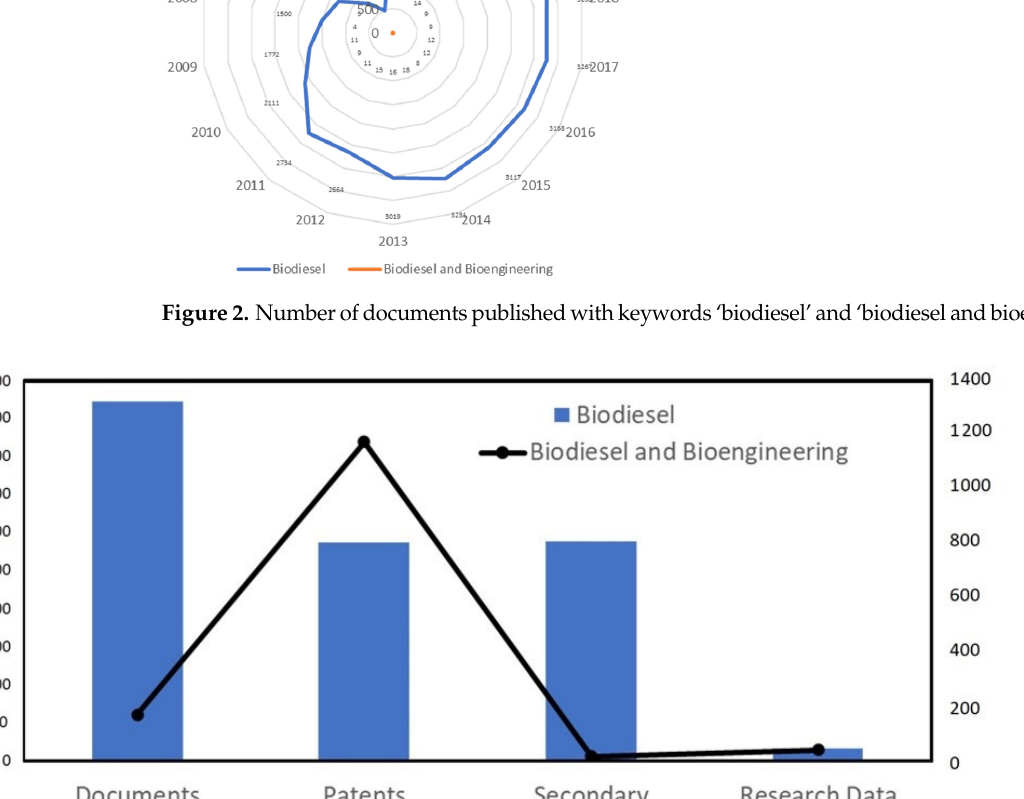
Figure 4. Patents published with different patent offices with keywords ‘biodiesel’ and ‘biodiesel and bioengineering’. ( A )